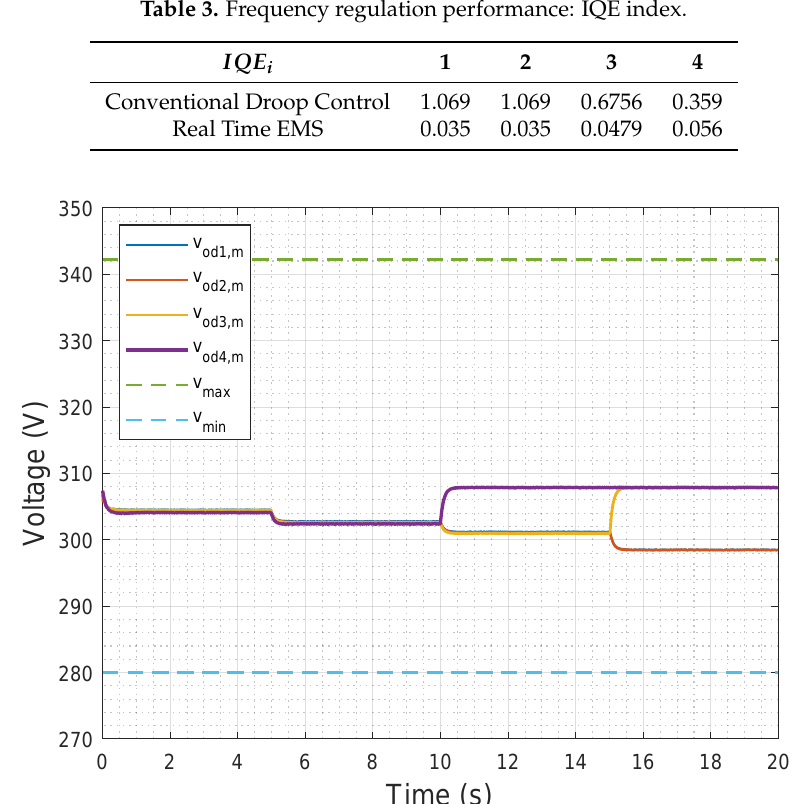
Figure 11. Voltage profile with the real-time EMS. The direct components of the output voltage of each IDG ( v od 1, m , v od 2, m , v od 3, m , v od 4, m ) are shown in this figure. The voltage limits restrictions of ± 10% of the nominal voltage amplitude ( v max , v min ) are not violated in any time of the